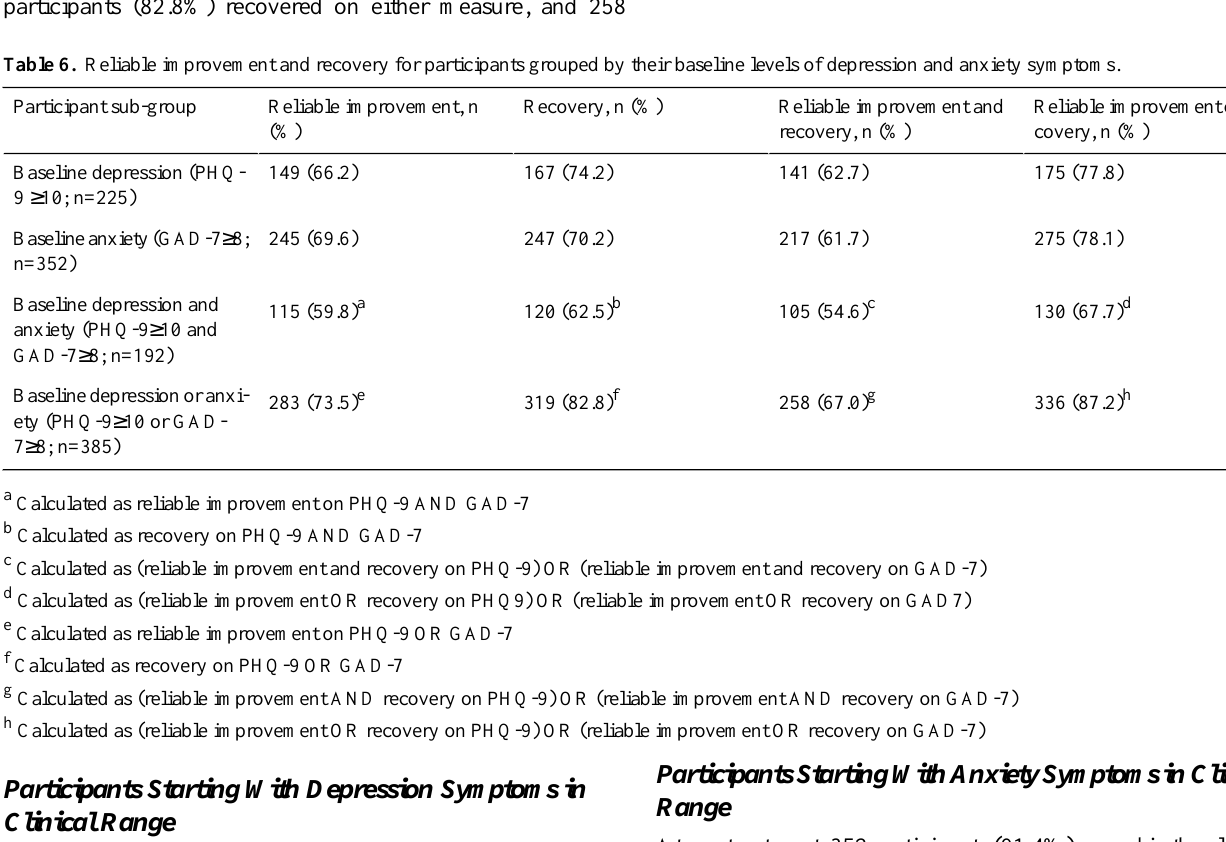
Table 6. Reliable improvement and recovery for participants grouped by their baseline levels of depression and anxiety symptoms.